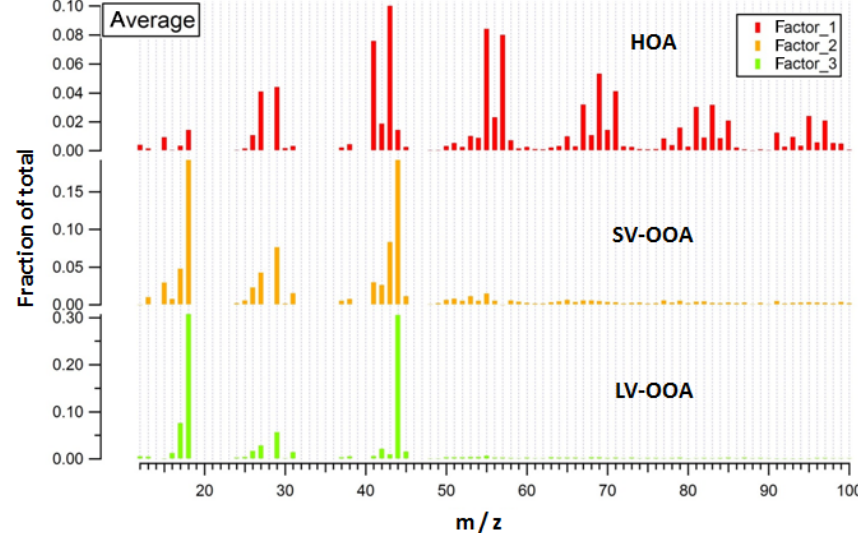
Figure 10. Mass spectra profile obtained for the three-factor-constrained PMF solution (factor 1 = HOA, red; factor 2 = SV-OOA, orange; factor 3 = LV-OOA,